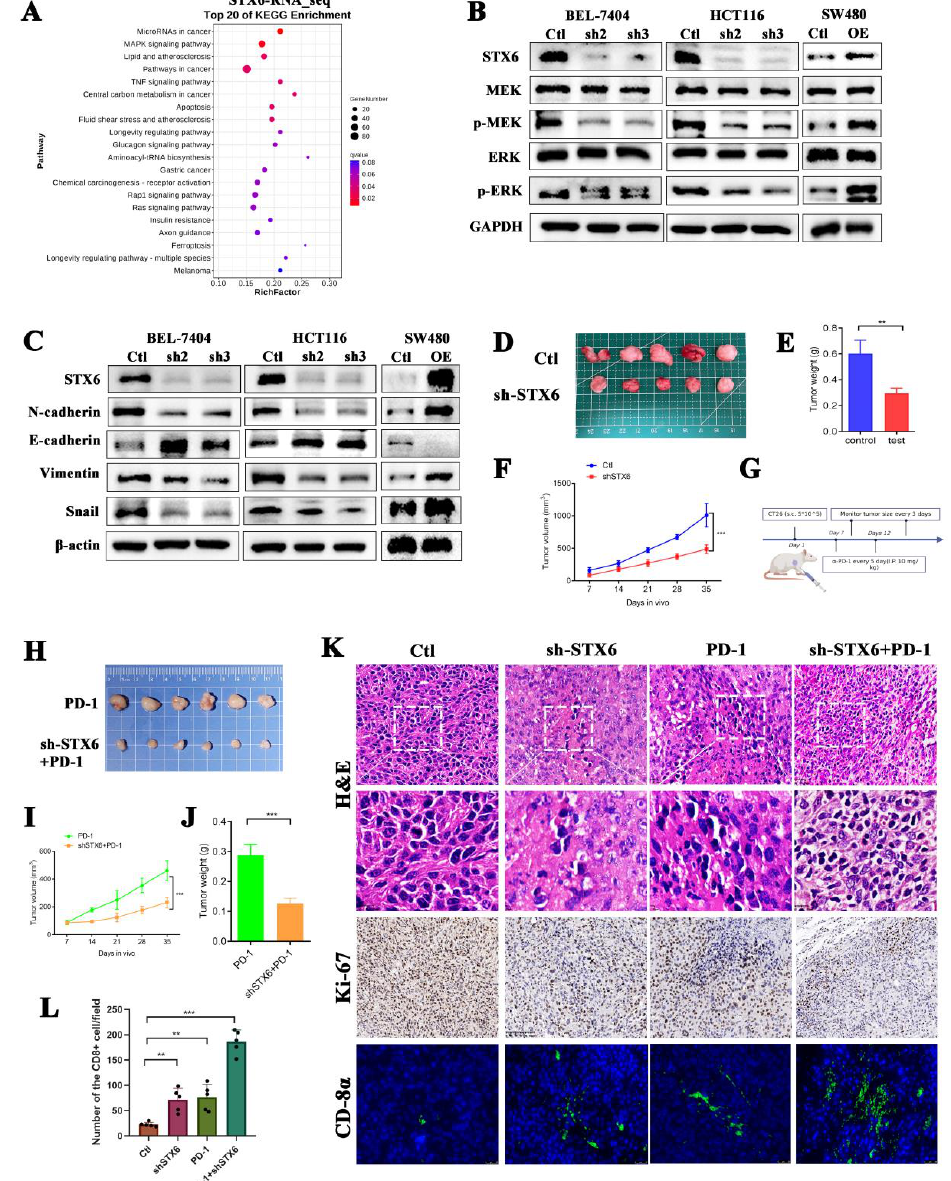
Figure 8. Knockdown of STX6 expression inhibited tumor formation and promoted CD8 cell infiltra- tion in a mouse model. The RNA-seq results about the knockdown of STX6 in BEL-7404 cells showed that STX6 is involved in cancer pathways, microRNA cancer pathways, and MAPK signaling path- ways ( A ). Knocking down STX6 levels arrested the MAPK/ERK pathway and EMT pathway in HCC and CRC cells, while overexpression of STX6 promoted the activities of the above two pathways ( B , C ). Tumor weight and volume decreased when they were formed subcutaneously by injection of CT26 cells with silencing of STX6 ( D – F ). Schematic diagram of CT26 subcutaneous tumorigenesis and anti-PD-1 therapy plan ( G ). Silencing the STX6 level potentiated the anti-PD-1 efficacy in the mouse model ( H – J ). The immunofluorescent test (immunohistochemistry) showed that the scores of tumor proliferation-related indices in the STX6 knockdown group or STX6 knockdown combined with anti-PD-1 therapy were lower than those in the control group or anti-PD-1 therapy respectively and promoted CD8 cell infiltration in the mouse model ( K , L ). ** p < 0.01, *** p < 0.001. The whole Western Blot can be found in file